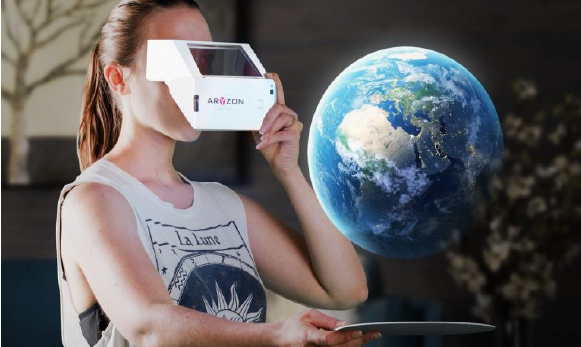
Figure 1. AR Lowcost Aryzon system, presentation image from